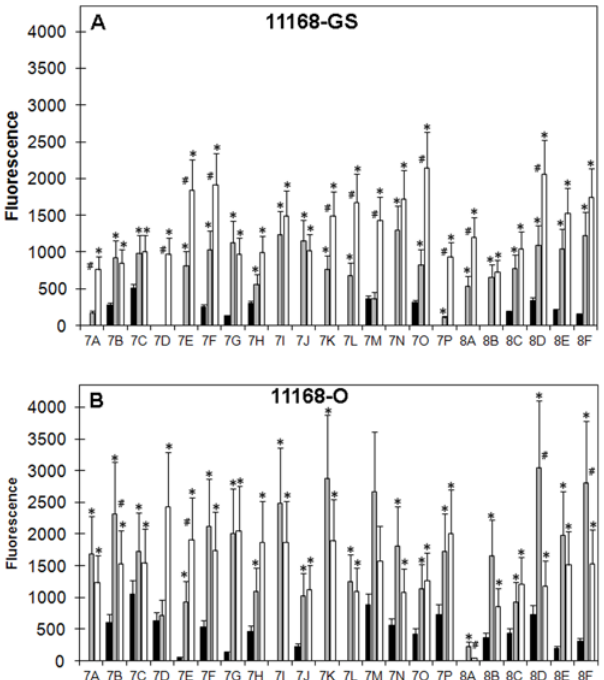
Figure 3. Binding of C.jejuni 11168 to fucosylated structures. Fluorescence intensities associated with C. jejuni 11168-GS (A) and C. jejuni 11168-O (B) binding to fucosylated glycans (25 u C, black bar; 37 u C, grey bar; and 42 u C, white bar). For the structure of the individual glycans refer to Table 2. * Significantly different to 25 u C, P , 0.05; # Significant difference between 37 u C and 42 u C, P ,